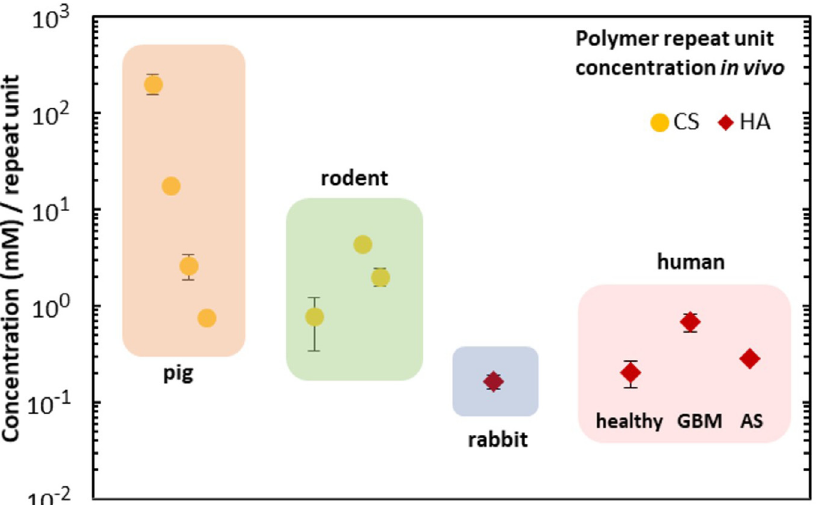
Figure 7. Summary of concentrations of hyaluronic acid (HA) and chondroitin sulfate (CS) in the brain of various species. The concentration of HA in healthy tissue, glioblastoma, and astrocytoma is also plotted.